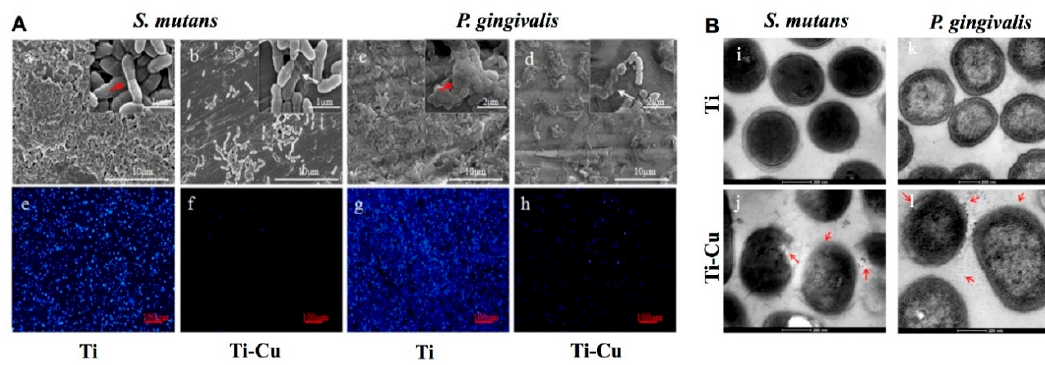
Figure 8. Antibacterial effect of titanium alloy (Ti-Cu). ( A ) SEM micrographs and DAPI images of S. mutans and P. gingivalis on surfaces of Ti ( a , c , e , g ) and Ti-Cu alloy ( b , d , f , h ) after co-culture for 24 h. ( B ) TEM micrographs of inner structures of S. mutans and P. gingivalis , ( i , k ) treated with Ti; ( j , l ) treated with Ti-Cu alloy [143]. Copyright 2016 Springer Nature.